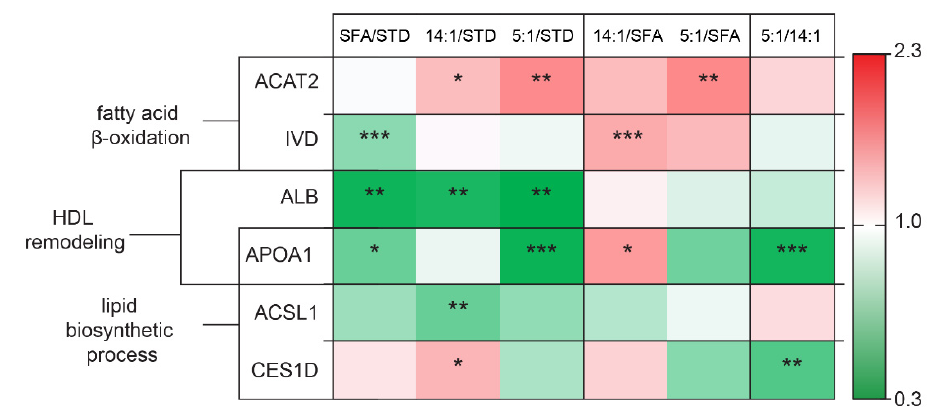
Figure 6. Changes in the abundance of proteins involved in lipid metabolism. The statistically significant ( p < 0.05) value of the average intensity of the SFA, 14:1 and 5:1 groups compared to the STD group; the 14:1 and 5:1 groups compared to the SFA group; the 5:1 group compared to the 14:1 group. The significance of differences estimated using the model (1).